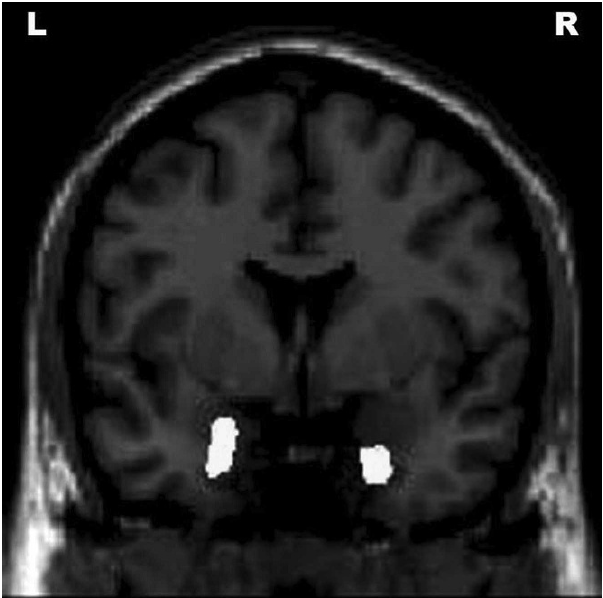
Figure 2 - Correlations between Functional Activities Ques- tionnaire scores and reduced gray matter volume in different areas of the brain. The results are displayed at an uncorrected p , 0.001 level and plotted onto the SPM5 canonical T1 image for the purpose of illustration. R = right; L = left.